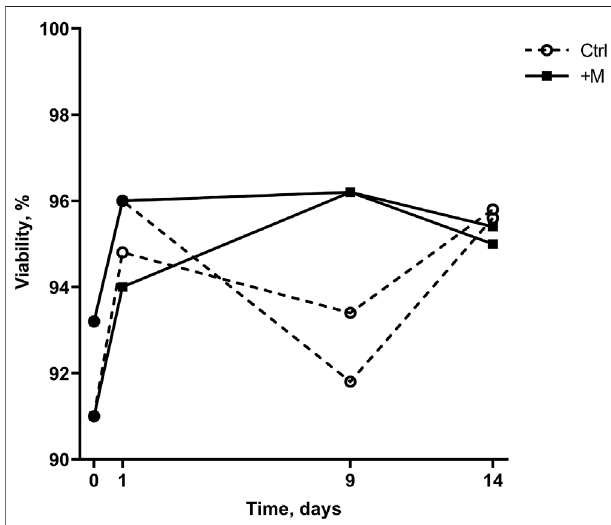
FIGURE 4 | Numbers of apoptotic (A) and necrotic (B) cells in 500-cell samples of the control and MF-exposed cells cultivated for 14 days.